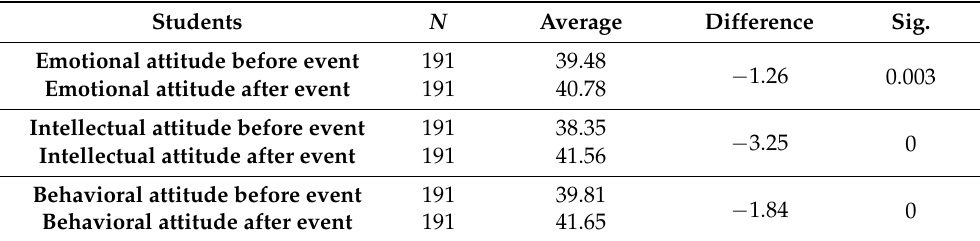
Table 6. Results of the students’ surveys compared by time period.